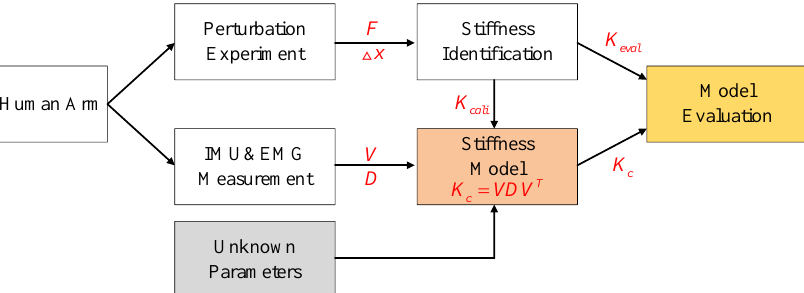
Figure 1. Graphical illustration of the main blocks in this work. F and ∆ x represent interaction force between human and robot and corresponding displacement respectively. V and D represent the orthonormal matrix consisting of eigenvectors and the diagonal matrix consisting of eigenvalues. K c , K cali and K eva represent the estimated human arm endpoint stiffness from the proposed model and the collected human arm endpoint stiffness samples used for calibration and evaluation